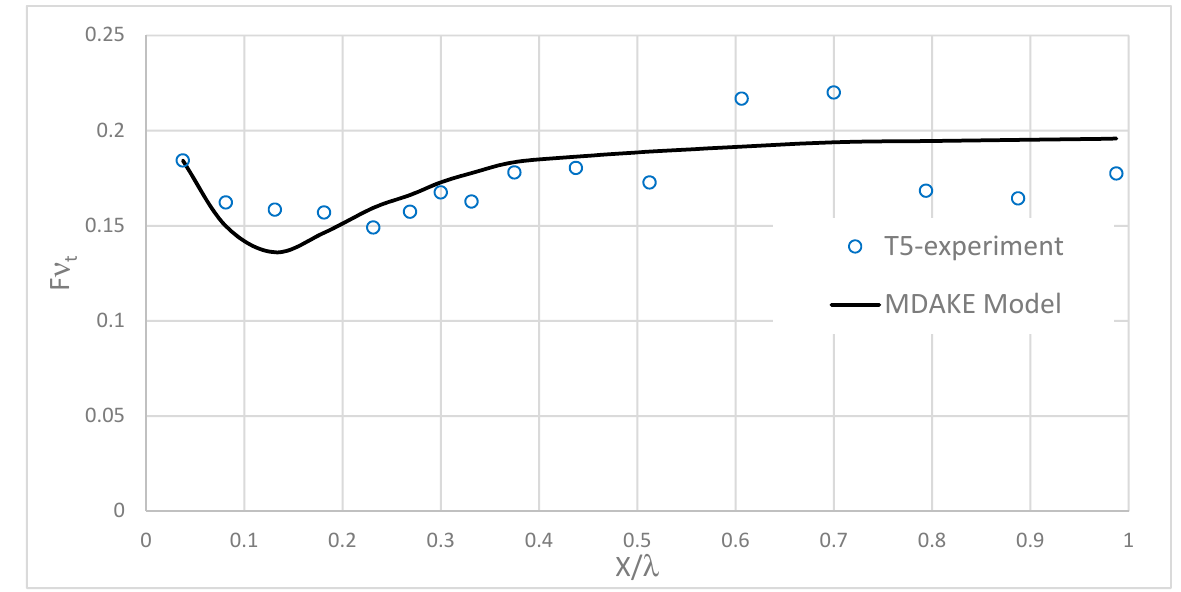
Figure 7. Spatial distribution of eddy viscosity coefficient over one wavelength of bedforms (data from experiment T5).